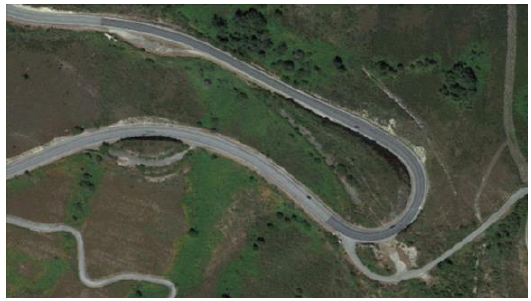
Figure 3. Survey van with Optech Lynx Mobile Mapper.